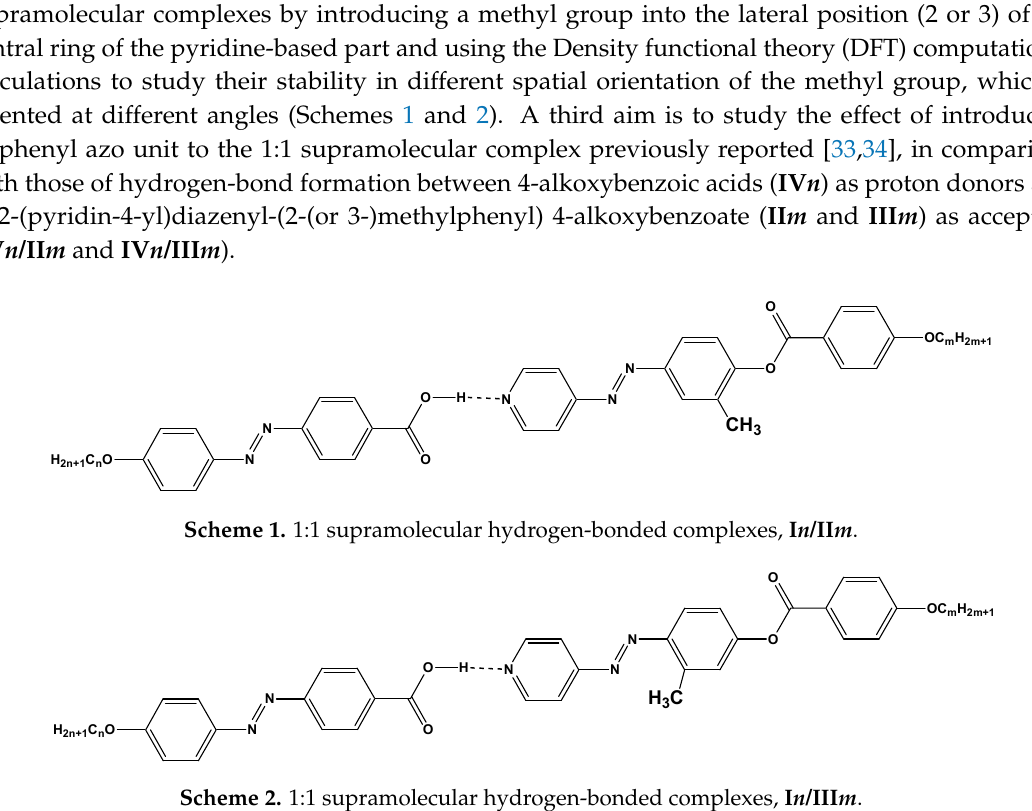
Scheme 2. 1:1 supramolecular hydrogen-bonded complexes, I n /III m .